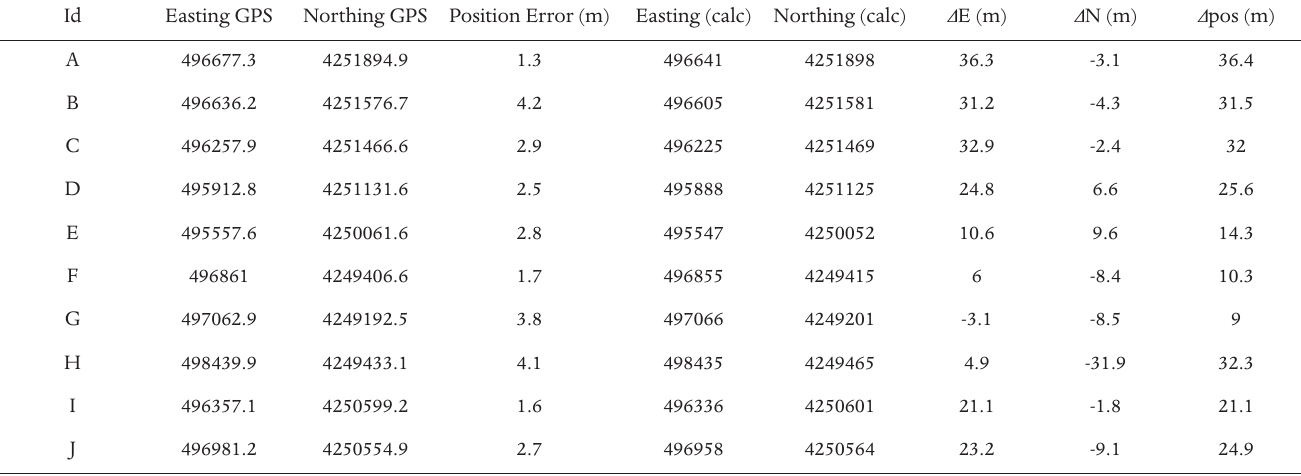
Table 2. Measured GPS points (UTM WGS 1984) acquired during the August 28, 2008, survey. The calculated values (calc) are from the transformation of the original Gauss Boaga coordinates taken from the georeferenced CTR map of Vulcano Island; D E, D N and D pos are the residuals between the measured and calculated Easting, Northing and position,